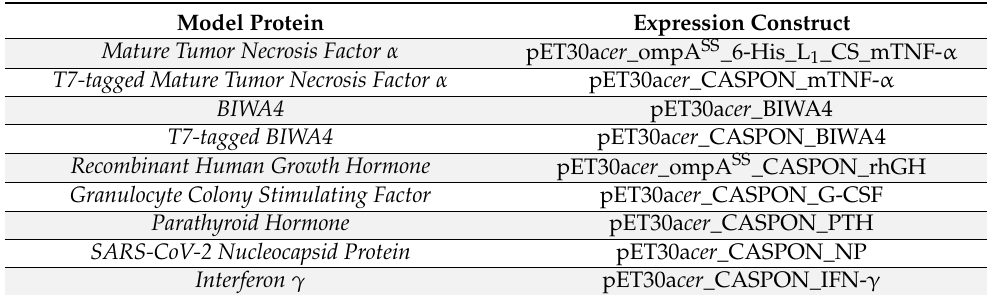
Table 2. Additionally tested model proteins with corresponding expression constructs. Model